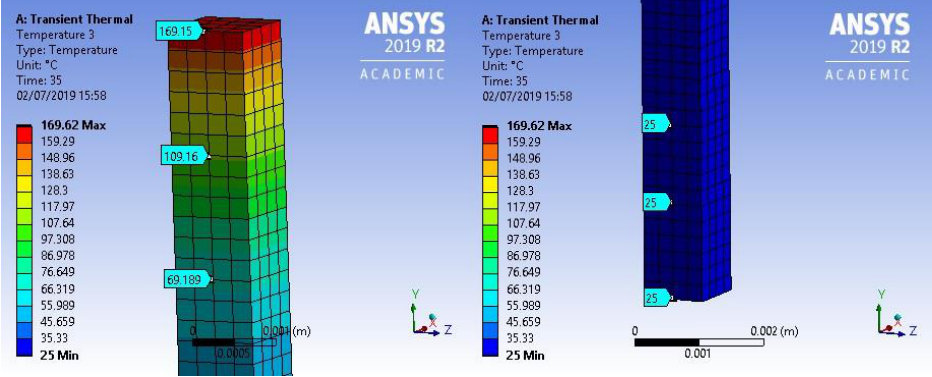
Figure 8. The temperature profile at t = 35 s is shown for the first top layer ( left ) and the last bottom layer ( right ).